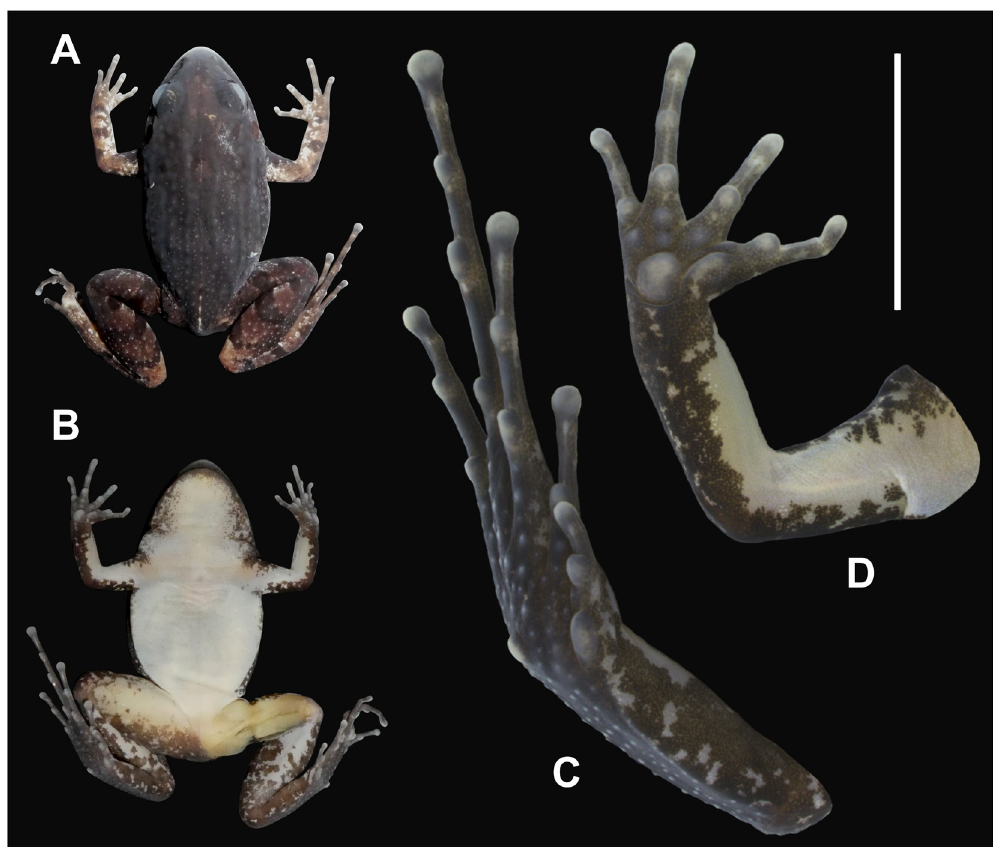
Fig. 3. Preserved male of nominal Adenomera simonstuarti (Angulo & Icochea, 2010) (= genetic lineage 3): call voucher INPA-H 40967 (SVL = 23.4 mm) from the upper Juruá River, in Tarauacá, Brazilian state of Acre. This specimen corresponds to a call voucher (see Fig. 5). A−B . Body in dorsal and ventral views, not to scale. C−D . Detail of the ventral surface of right foot and hand, respectively. Note the nearly solid, dark-colored stripe along the underside of the forearm. Photographs by J. Magnusson. Scale bar = 5